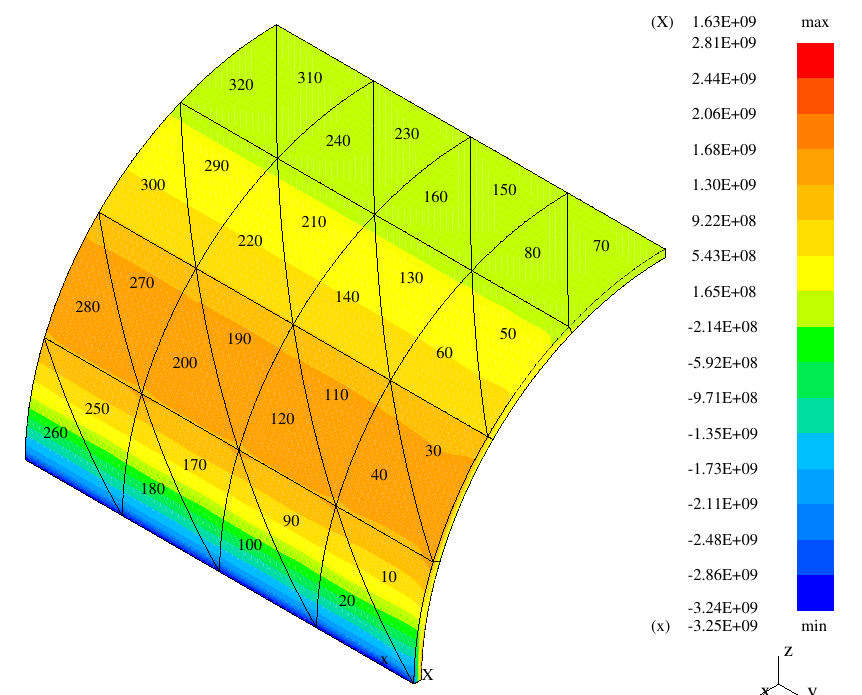
Figure 14. Third normal stress—the bent shell with the classical transition elements.